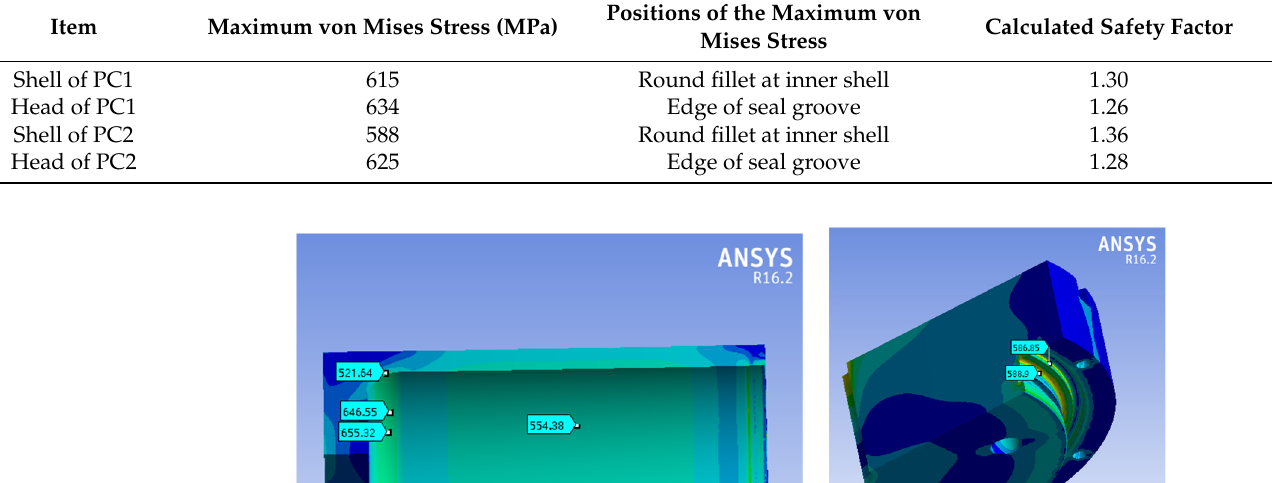
Table 4. FEM results for pressure hulls.